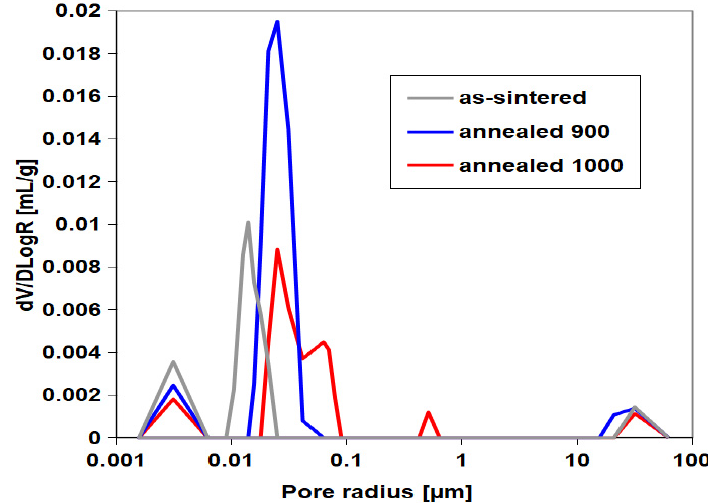
Figure 9. Change of porosity due to annealing of the SPS sample A.